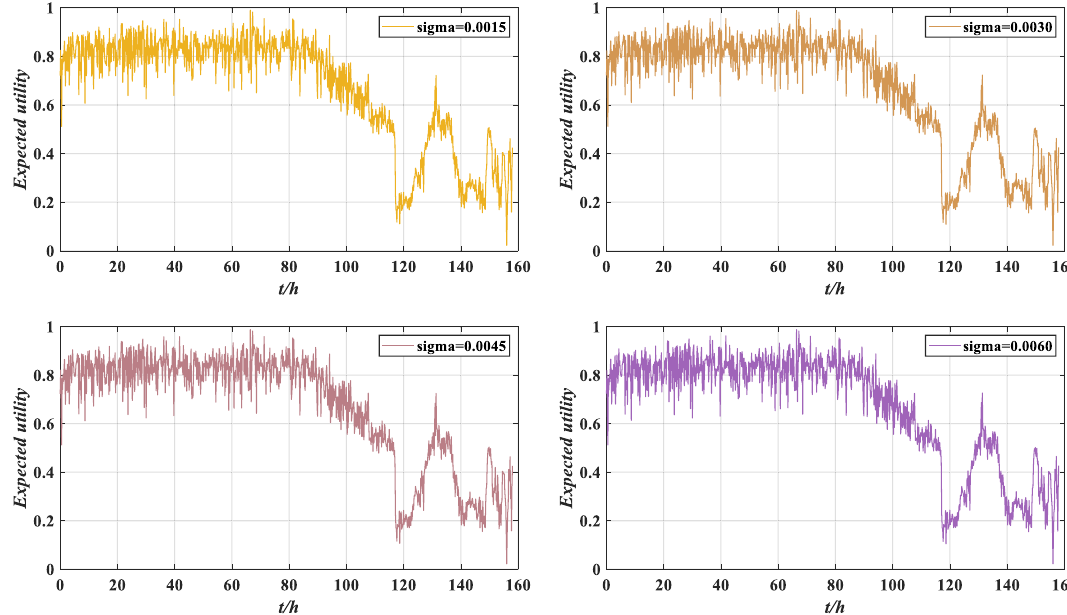
Figure 13. Expected utility of rolling bearing performance under different perturbation intensities.